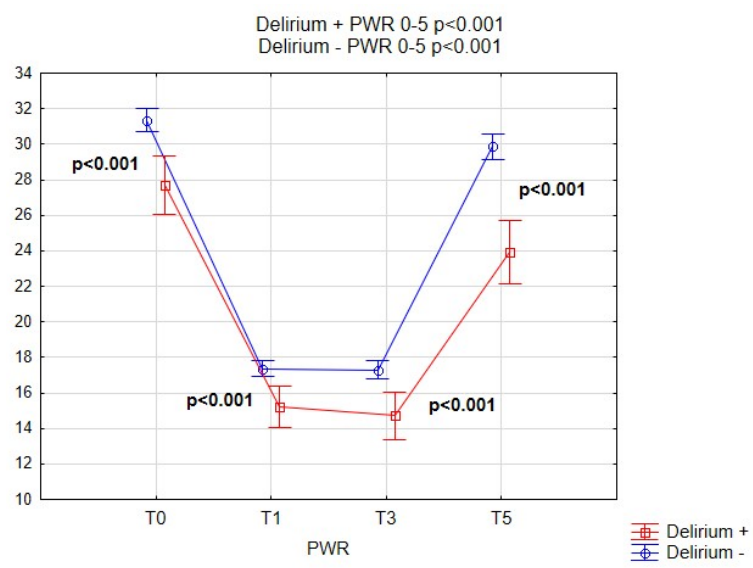
Figure 4. Pre-operative and post-operative PWR values for patients with and without POD. PWR, platelet-to-WBC ratio; POD, Postoperative delirium.